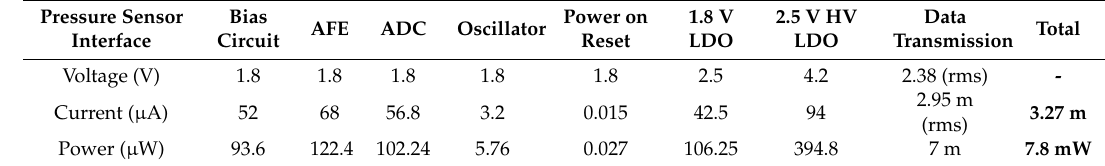
Table 2. Power consumption of each